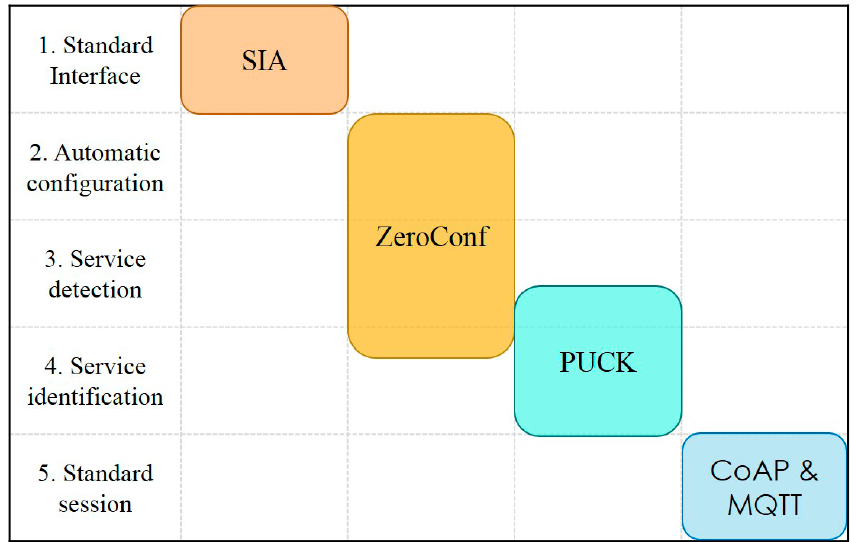
Figure 3. Protocols and standards adopted in the proposed scheme.